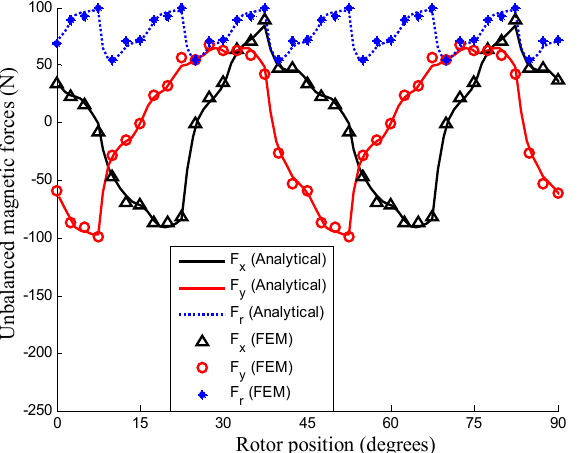
Figure 17. Total unbalanced magnetic forces exerted on the rotor.